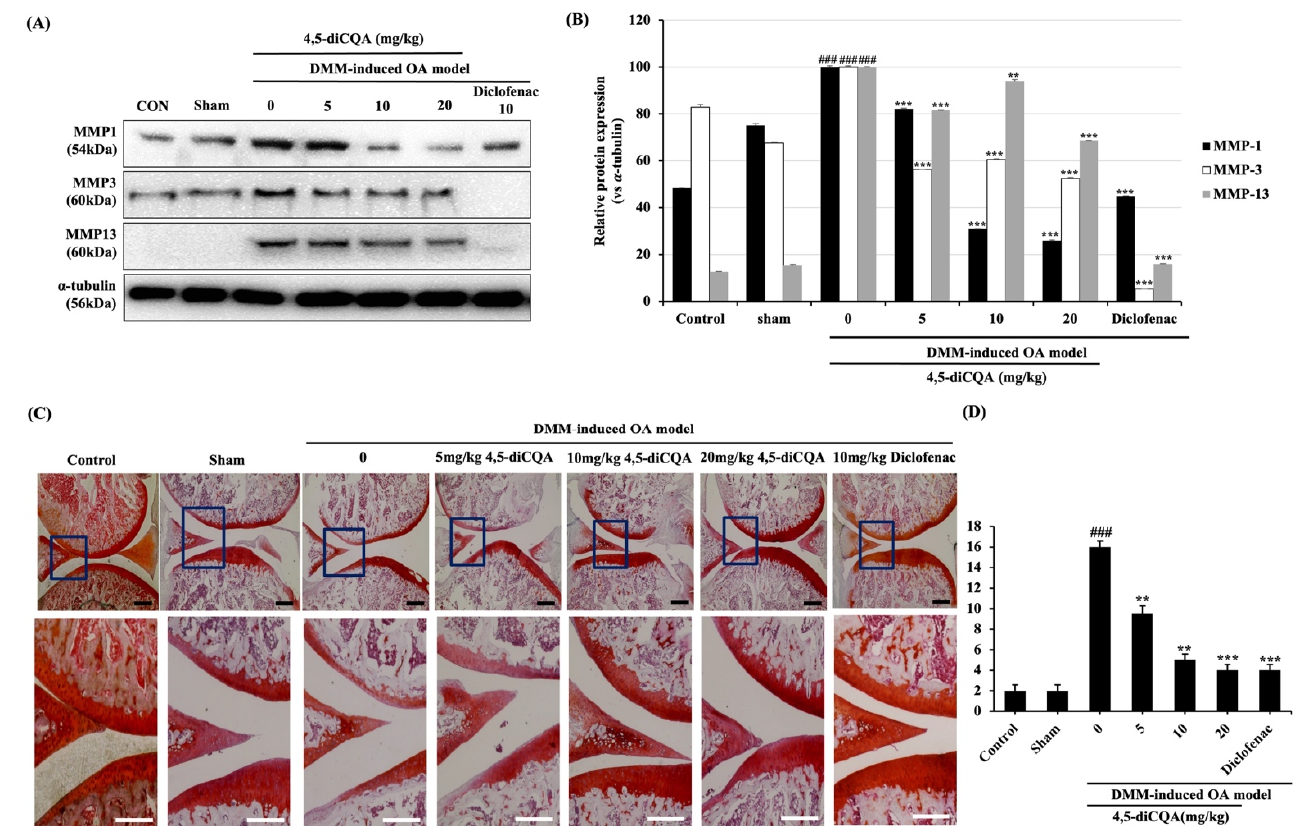
Figure 6. Histological evaluation of cartilage-protective effect of 4,5-diCQA against cartilage degradation in a DMM model. After sham or DMM surgery, rats received gavage of distilled water, 4,5-diCQA (5, 10, and 20 mg/kg bodyweight), or diclofenac sodium (10 mg/kg bodyweight) every other day for 2 weeks. ( A ) Protein levels of MMP-1, -3, and -13 were determined using Western blot analysis. α − Tubulin served as an internal control. ( B ) Quantitative data of ( A ) were analyzed using the ImageJ bundled with Java 1.8.0_172 software. n = 5 per group. Data are represented as mean ± SD of three independent experiments. ### p < 0.005 compared with sham group; ** p < 0.05, and *** p < 0.005 compared with the DMM-induced group. ( C ) Histological analysis of cartilage destruction was evaluated by Safranin O/Fast green staining. Black scale bars, 500 μ m. White scale bars, 100 μ m. ( D ) Osteoarthritis Research Society International (OARSI) advanced Osteoarthritis Cartilage Histopathology Assessment System. ANOVA and Dunnett tests were used to evaluate the significance of the results. ### p < 0.005 compared with sham group; ** p < 0.05, *** p < 0.005 compared with DMM group. Table 1. Osteoarthritis Research Society International (OARSI) score.